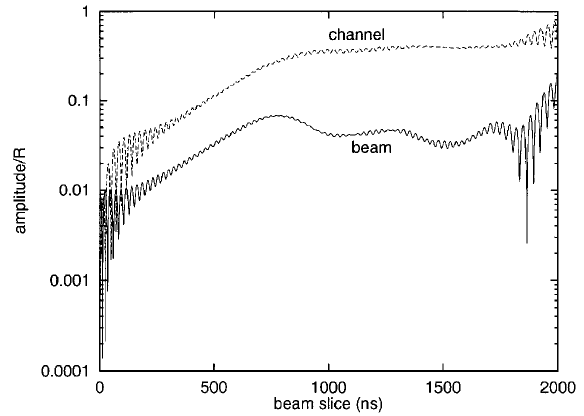
FIG. 4. Amplitude of the beam and channel displacements (in units of the beam radius R ) from numerical integration of the nonlinear model